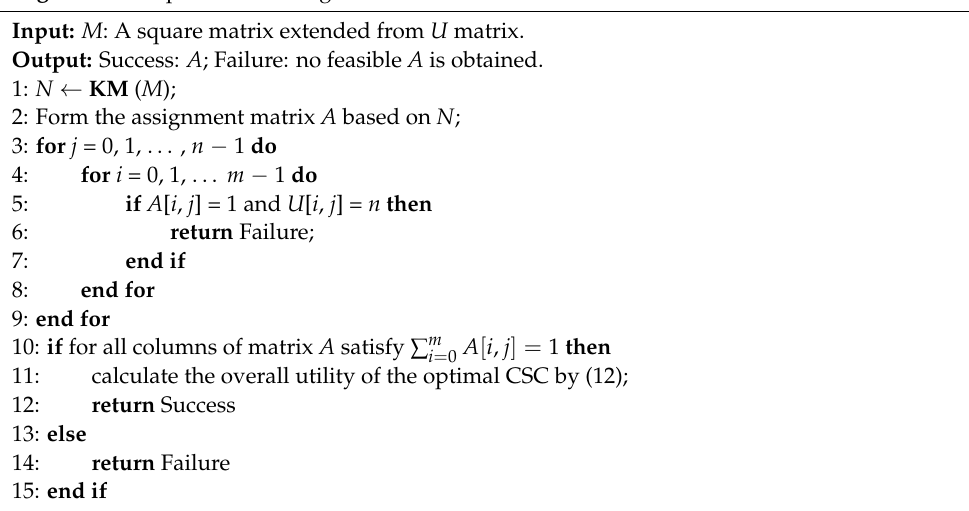
Algorithm 3: Optimal task